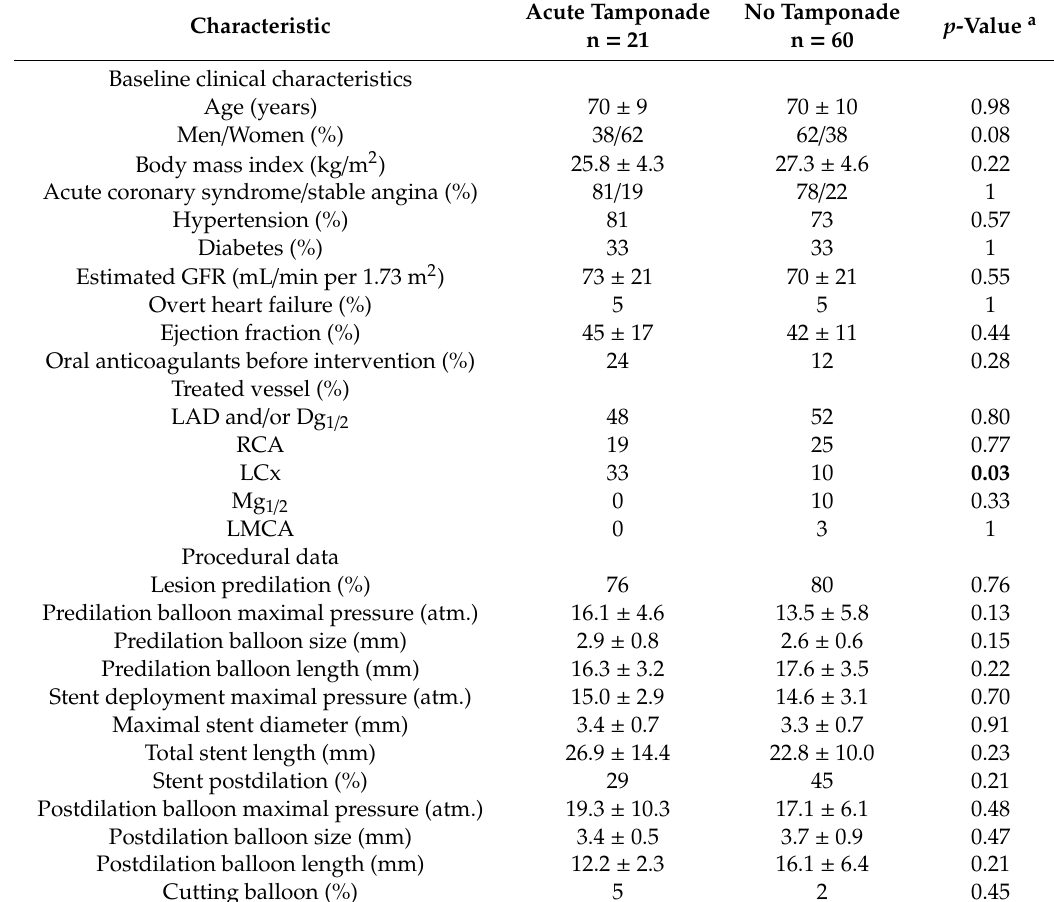
Table 1. Characteristics of patients experiencing grade III coronary artery perforation with and without acute cardiac tamponade requiring urgent pericardiocentesis in the cathlab. Acute Tamponade Characteristic n = 21 Baseline clinical characteristics